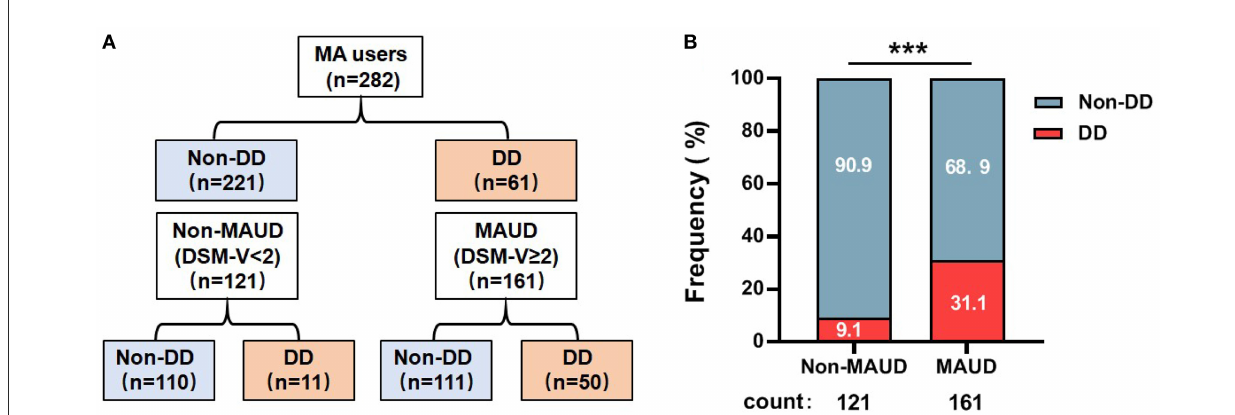
FIGURE1 Frequency of individuals with DD among the patients with MAUD. (A) The structure of the 282MA users involved in our research. A total of 161 individuals were diagnosed with MAUD; among them, 50 individuals had DD. (B) The results of the proportion of DD individuals among patients with MAUD (DSM-V ≥ 2) and MA users only (DSM-V < 2), *** p < 0.001; chi-square test. MA, methamphetamine; MAUD, methamphetamine use disorder; DD, depressive disorder.